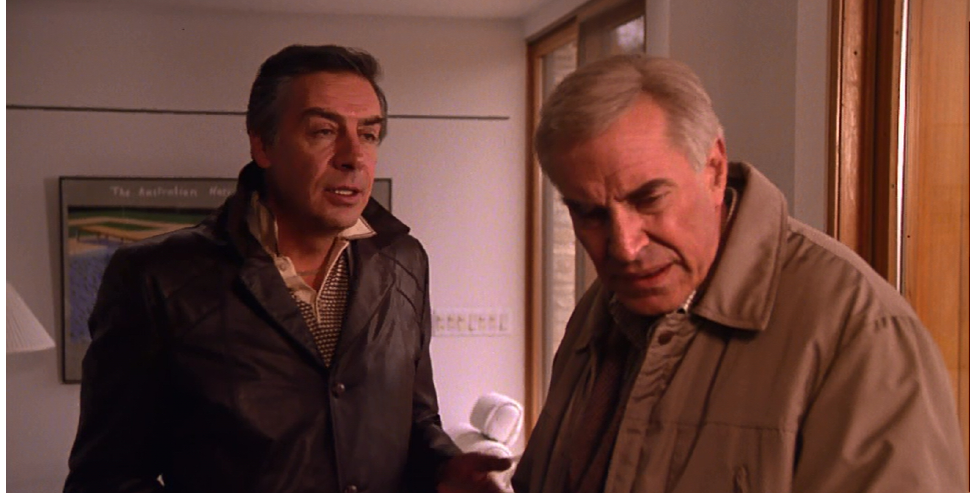
Figure 3: Judah (right) with his brother Jack (Jerry